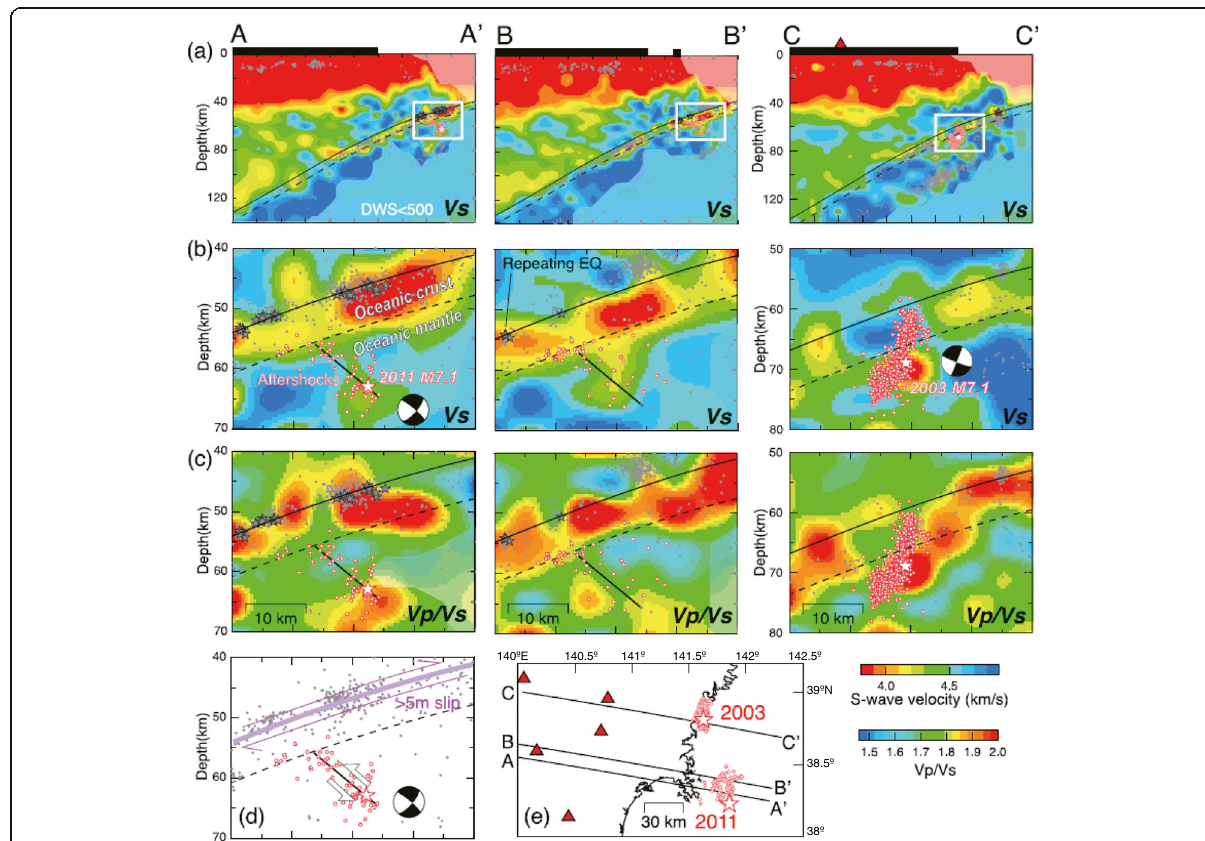
Fig. 18 Seismic velocity structure in and around the source area of the 2011 M 7.1 Miyagi – Oki intraslab earthquake. a Across-arc vertical cross- sections of S-wave velocity under central Tohoku along three lines : A – A' , B – B' , and C – C' in the inset map e. White stars in line A – A' and line C – C' denote the hypocenter of the 2011 M 7.1 event and the 2003 M 7.1 event, respectively. Solid and dashed black curves denote the upper surface of the Pacific slab and the Moho within it, respectively. White rectangle in a shows the area enlarged in b and c. b Across-arc vertical cross-sections of S- wave velocity and c Vp/Vs within the area outlined by the white rectangle in a . Black lines in A – A' and in B – B' show the fault plane of the 2011 M 7.1 event. d Schematic figure showing fault slips of the 2011 M 9.0 Tohoku – Oki earthquake ( purple arrows ) and the M 7.1 intraslab event ( white arrows ). e Map showing the aftershock distribution of the 2011 and 2003 intraslab events and the locations of the three lines, A – A' , B – B' , and C – C' . (After Nakajima et al.